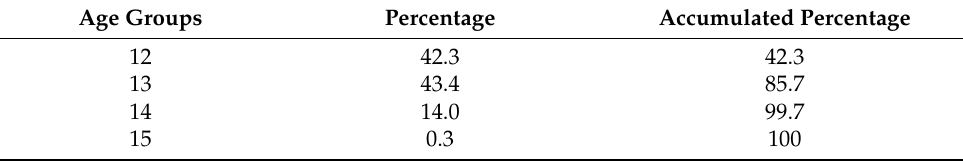
Table 1. Distribution by students’